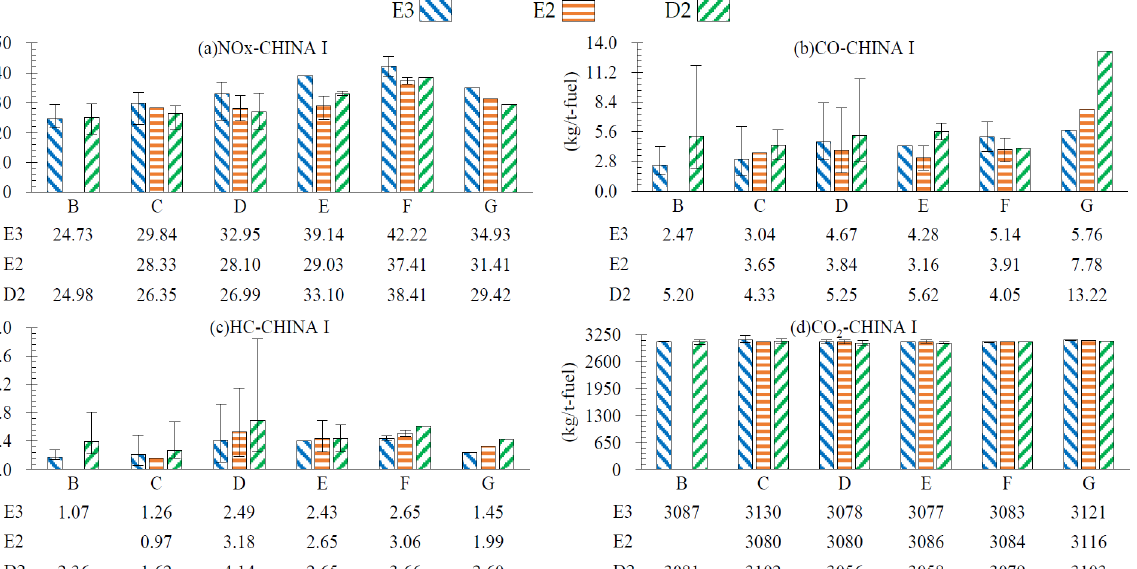
Figure 3. Fuel-based emission factors for different single-cylinder displacements under the CHINA II standard. ( a ) NOx-specific emissions in the E3, E2, and D2 cycles; ( b ) CO-specific emissions in the E3, E2, and D2 cycles; ( c ) HC-specific emissions in the E3, E2, and D2 cycles; ( d ) CO 2 -specific emis- sions in the E3, E2, and D2 cycles. 3.2. Energy-Based Average Emission Factors The mass flow rate for each exhaust gas component can be calculated according to the emission standards. With the corresponding test load point power, the energy-based emission factors for NO X + HC, CO, CO 2 , and PM can be calculated with Equations (2) and (3), as shown in Figures 4 and 5 and Tables S4 and S5. The calculation method for the margin is expressed in Equation (4), and Tables S4 and S5 list the margins for NO X + HC, CO, and PM.